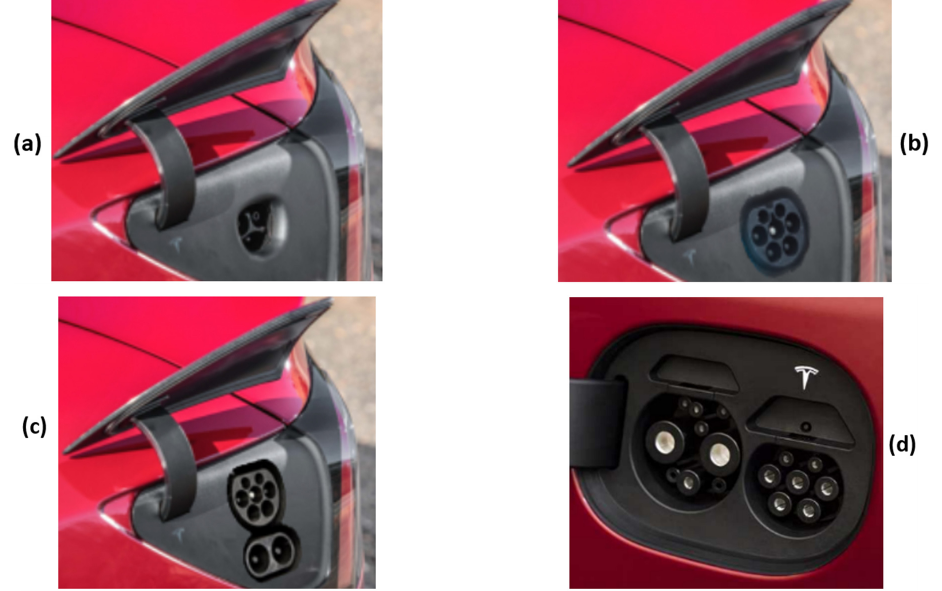
Figure 27. The Tesla EV inlet according to the region of sale: ( a ) US; ( b ) and ( c ) EU; ( d ) China.